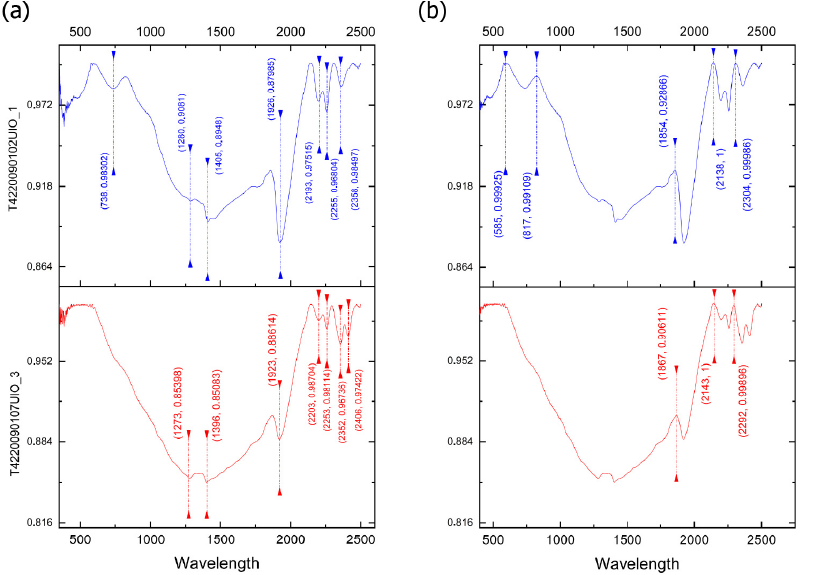
Figure 14. Absorption and reflectance peaks from spectra collected from samples of Tysfjord granite. ( a ) Main absorption peaks (minimum). ( b ) Main reflectance peaks.